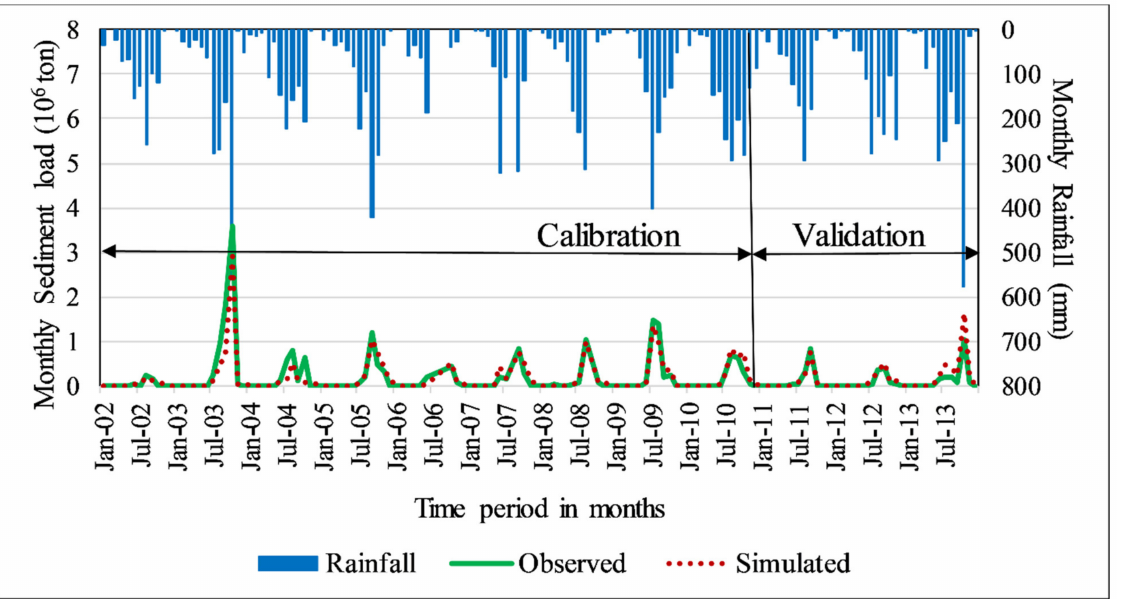
Figure 7. Observed versus simulated monthly sediment load during the calibration and validation period over the Vamsadhara river